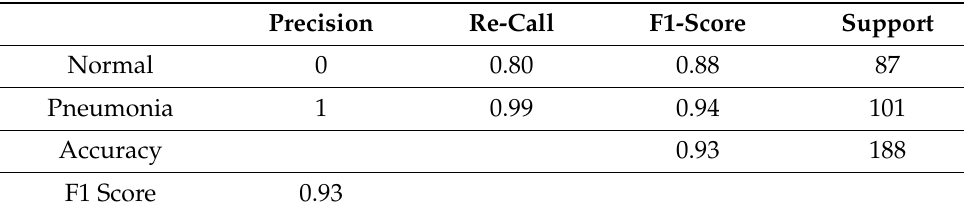
Table 4. Result analysis of the VGG16 model.